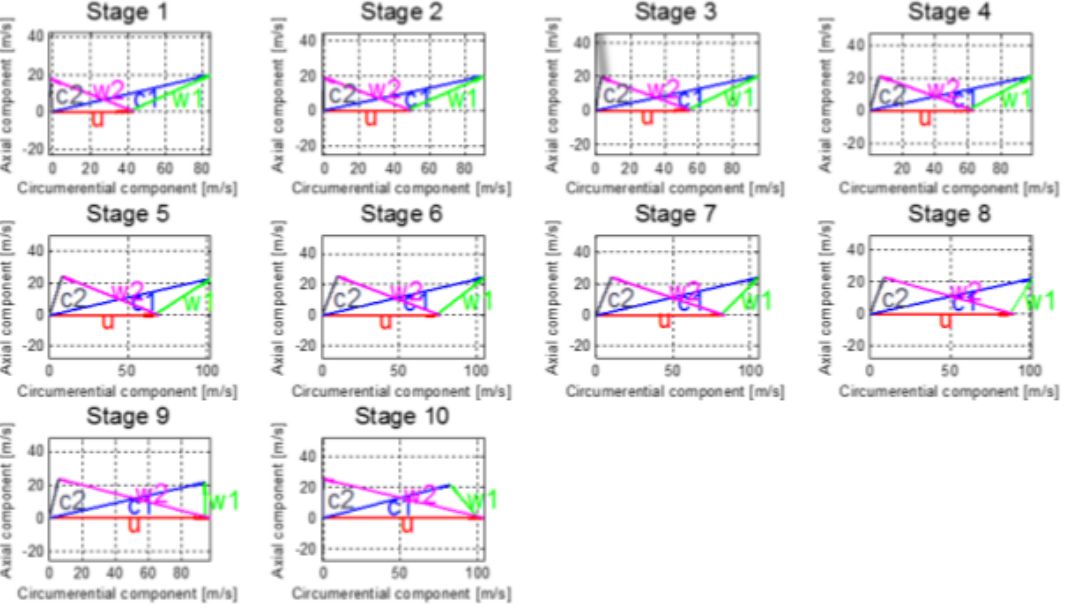
Figure 19: Velocity triangles of the 500 kW axial